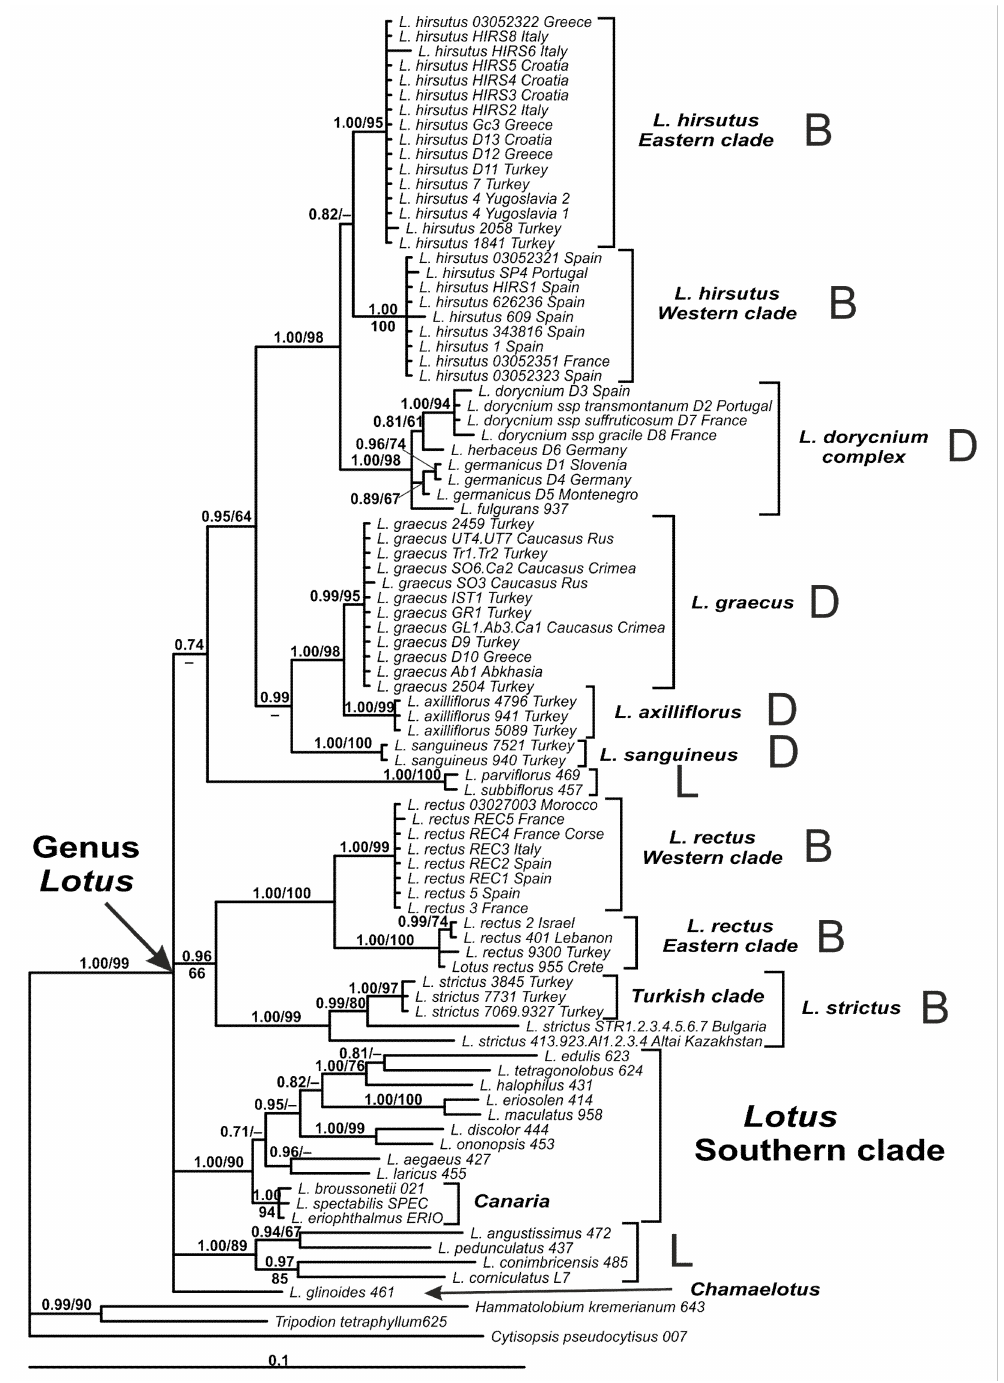
Figure 1. Phylogenetic relationships in Lotus inferred from Bayesian analysis of the ITS1-5.8S- ITS2 region (nrITS) dataset. Branch length is proportional to the number of expected nucleotide substitutions, scale bar corresponds to 0.1 substitutions per site. Numbers above branches are posterior probabilities. Numbers below branches or after slashes are bootstrap support values found in Maximum Likelihood analysis of the same dataset (values equal or more than 0.6/60% shown). Sections of the Northern evolutionary lineages of Lotus (according to Reference [3]) are marked with letters: B– Bonjeanea , D– Dorycnium , L– Lotus (incl. Erythrolotus ). Sample codes and country of origin for sequences are given after species names. See Appendix A for voucher